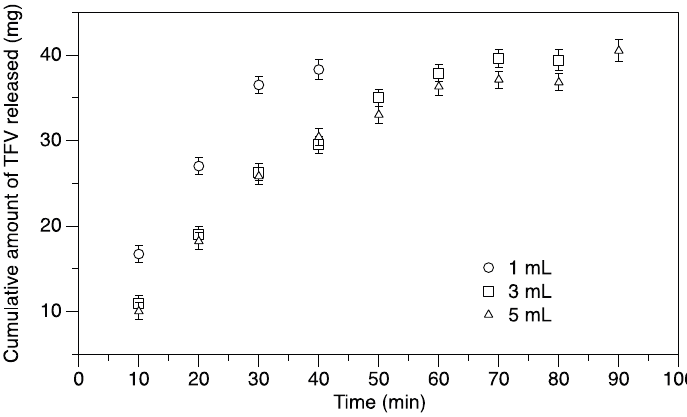
Figure 2. The effect of size on the release of tenofovir (TFV) from semisoft spherical suppositories in water. Release of TFV by matrix erosion from suppositories of 1, 3 and 5 mL loaded with 40 mg TFV each was studied, until the suppositories were fully eroded. Plotted are the mean and standard error ( n = 7) of the cumulative amount of TFV released.